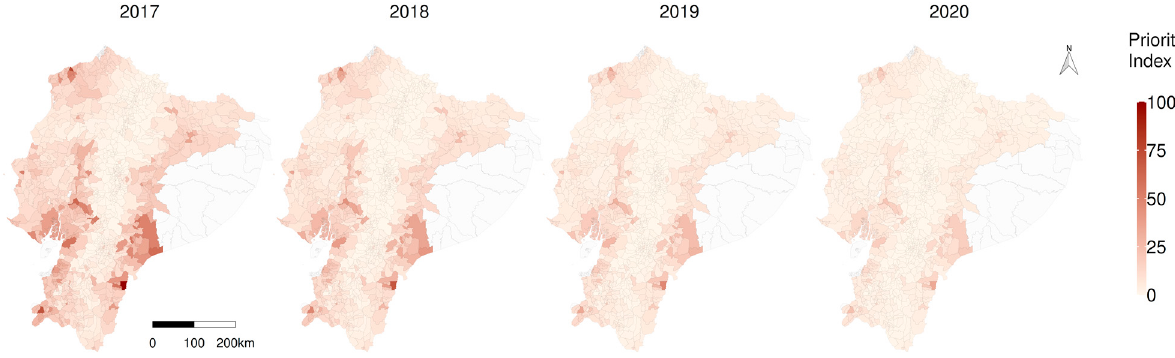
Figure 7. Spatiotemporal representation of the priority index (PI) to fight classical swine fever in Ecuador.